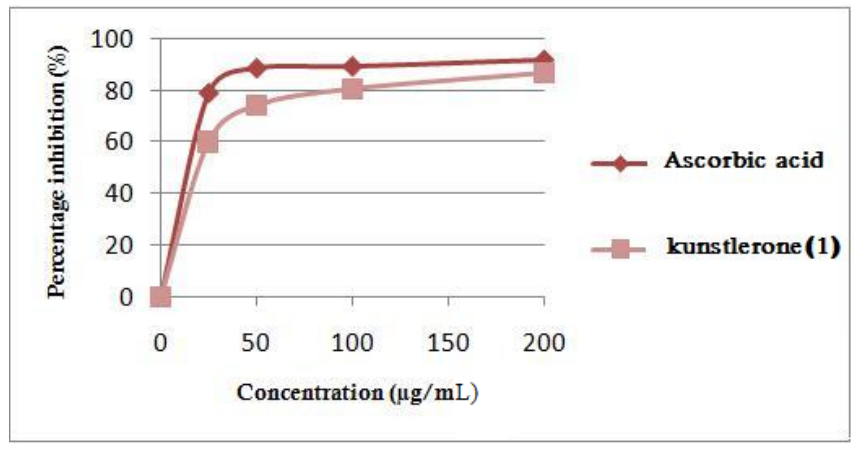
Figure 4. DPPH radical scavenging activity of the isolated new neolignan; (+)-kunstlerone ( 1 ) with an SC = 20.0 50